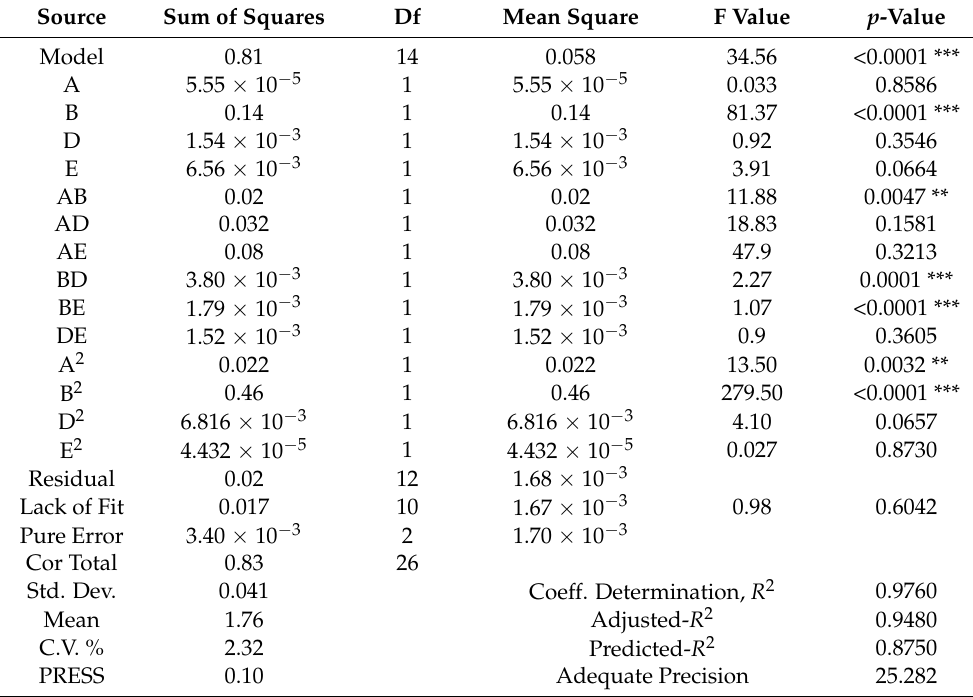
Table 5. Analysis of variance of TPH degradation by consortium BS24 in experimental